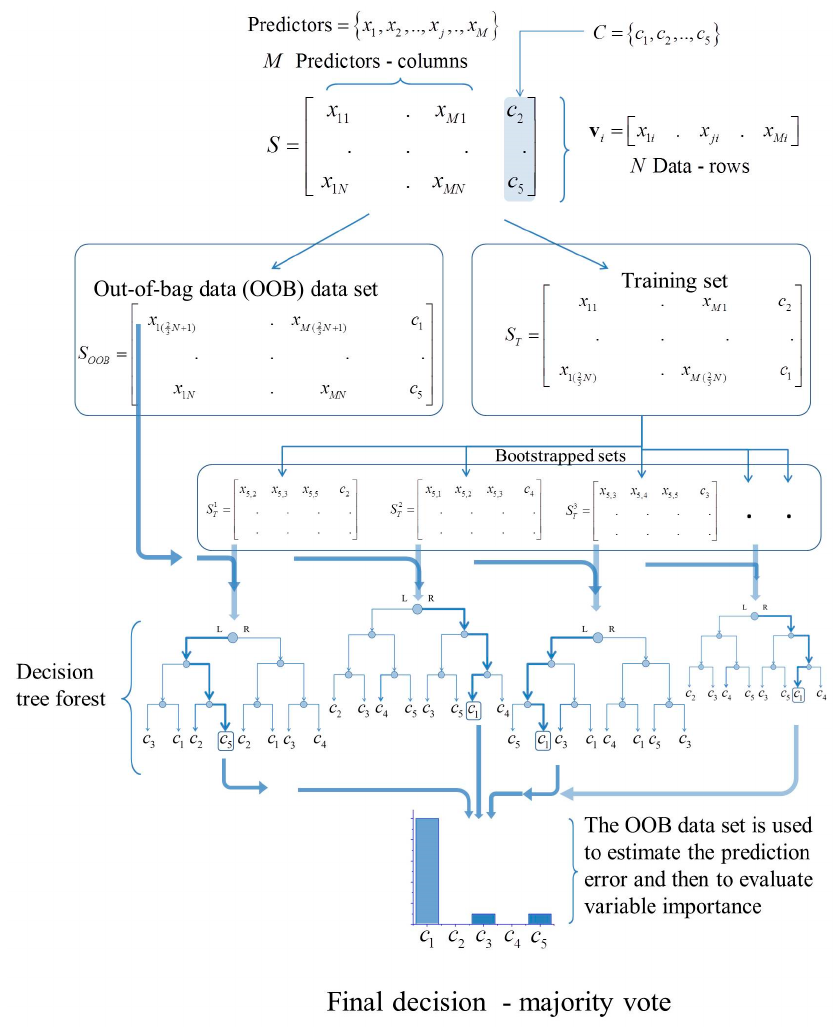
Figure 3. Information flows in the RFC. Only five classes and M predictors are taken into account. The random examination of the space of predictors is performed by selecting three predictors at random.